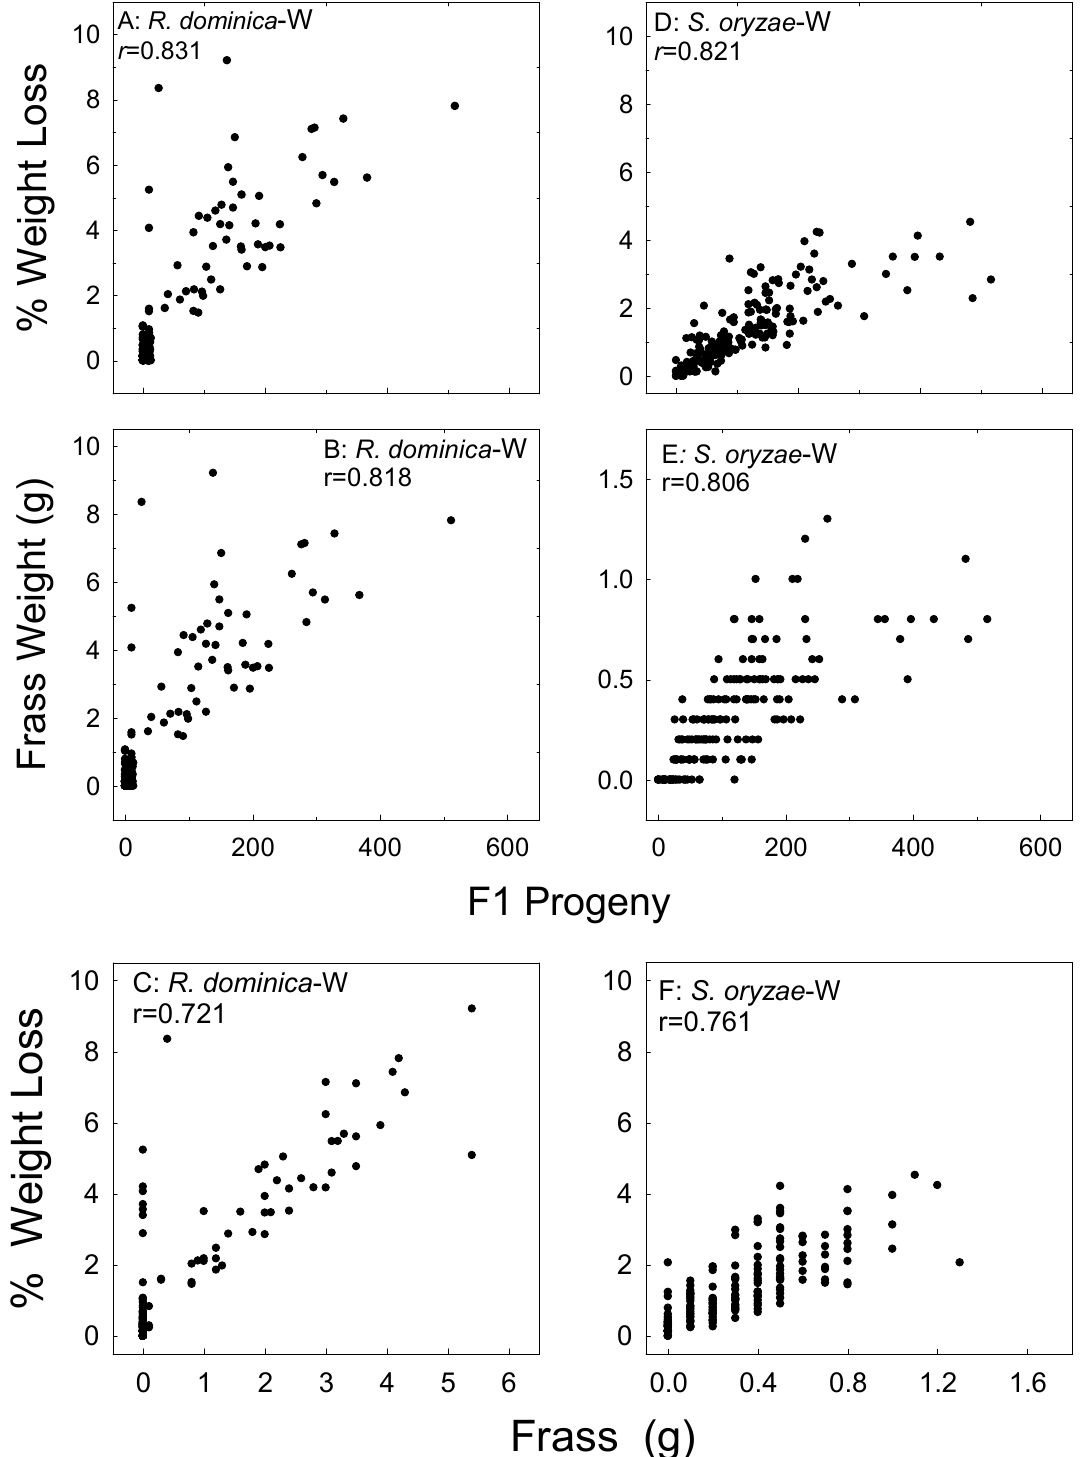
Figure 3. Correlation of wheat (W) sample weight loss and frass weight with F 1 progeny of R. dominica ( A , B ), sample weight loss with frass weight ( C ), sample weight loss and frass weight with F 1 progeny of S. oryzae ( D , E ), and sample weight loss and frass weight ( F ). Data for the two parental exposure regimes combined, data for all treatments and all bioassay months combined.